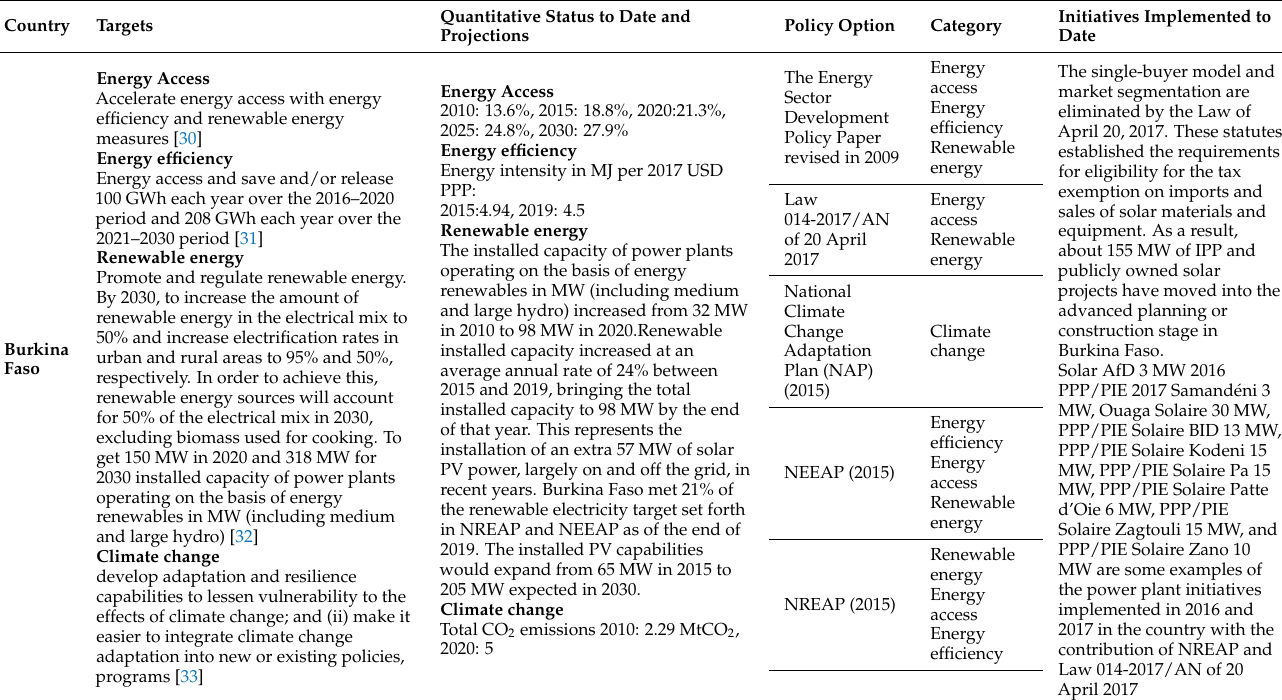
Table 2. Burkina Faso (data from [22–24]).